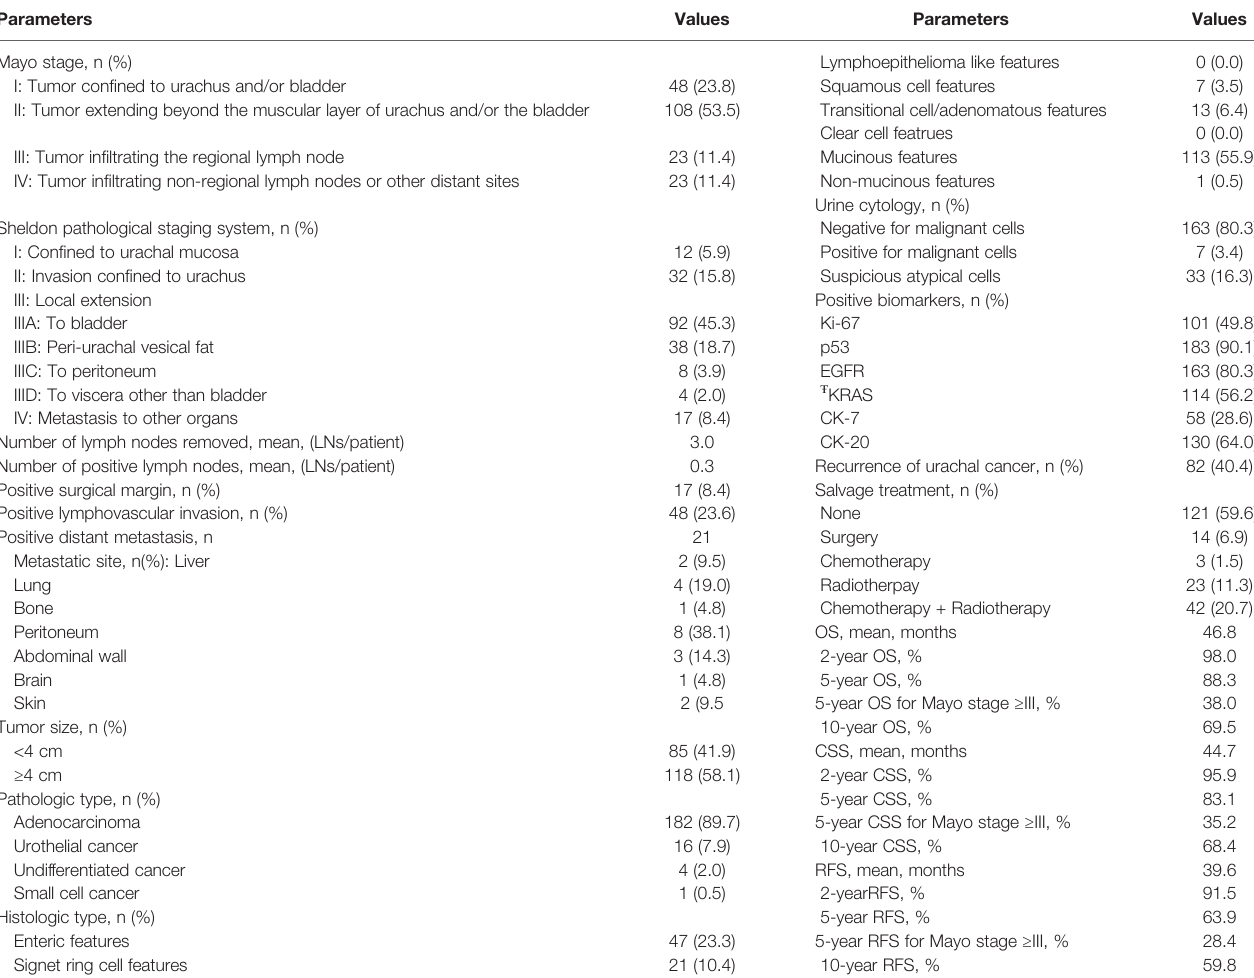
TABLE 2 | Pathological outcomes of urachal carcinoma patients, n = 203.